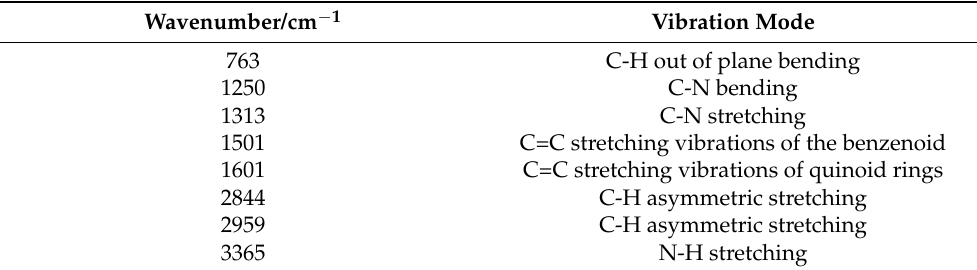
Figure 5. The Fourier transformation infrared spectroscopy (FT-IR) spectra of the PANI films de- posited on Si substrates using the newly designed AP plasma reactor with and without in-situ I 2 doping. Table 2. The FT-IR absorption peaks and corresponding molecular structures for the in-situ I 2 -doped PANI films deposited using the newly designed AP-plasma reactor system.